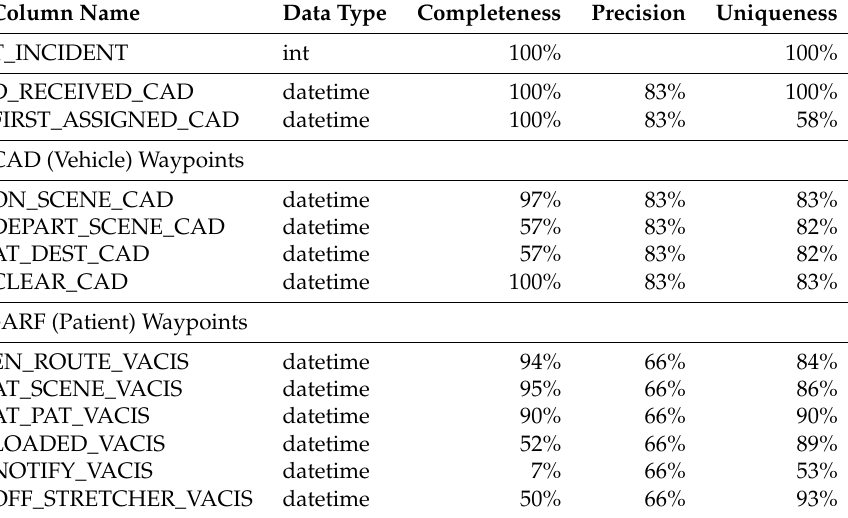
Table 2. QAS—Column-level data quality summary for a sample of